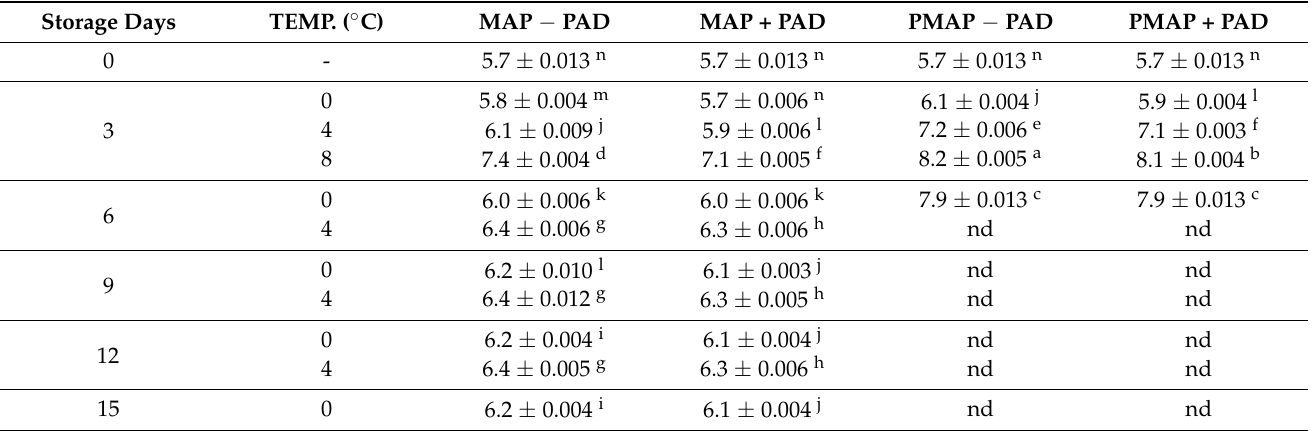
Table 1. Effects of storage temperatures (0 ◦ C, 4 ◦ C, and 8 ◦ C), duration (d), and modified atmosphere packaging with/without absorbent pads on pH of Cape hake